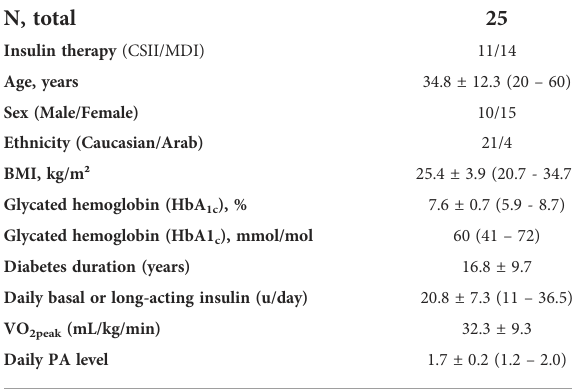
TABLE 1 Baseline characteristics of study